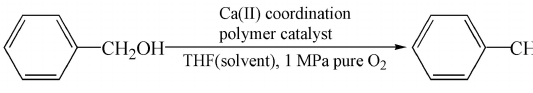
Figure 4. The conversion of benzyl alcohol